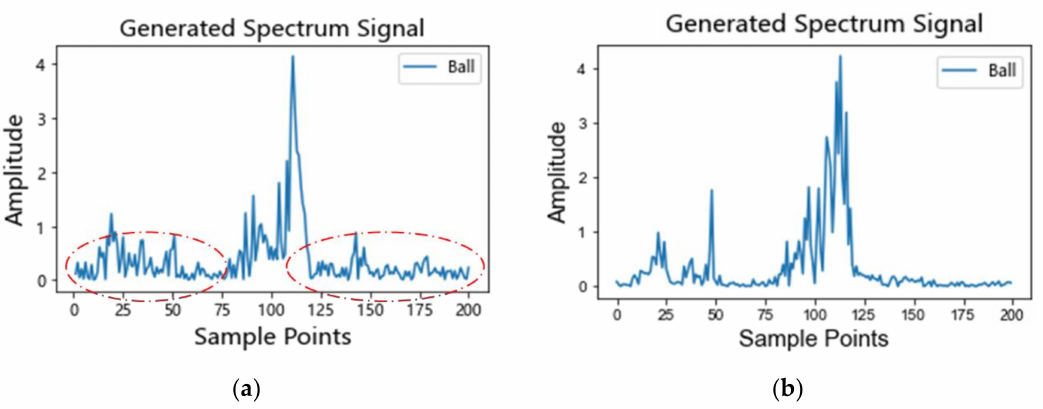
Figure 10. The comparison of MS-PGAN using the improved loss function MMD-WGP: ( a ) generated signal without MMD-WGP; ( b ) generated signal with